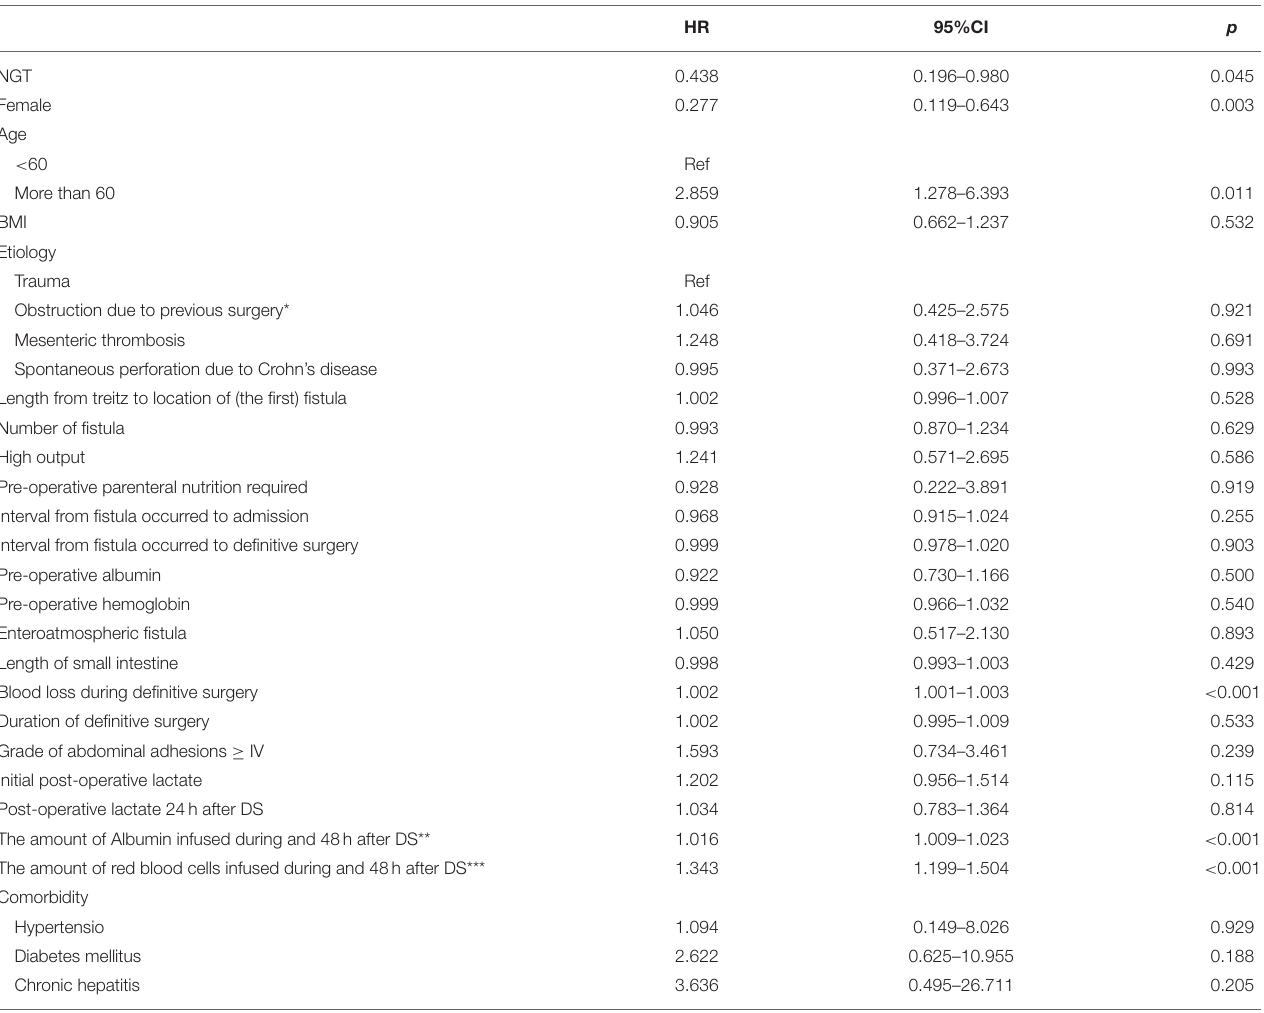
TABLE 2 | Unadjusted regression for post-operative